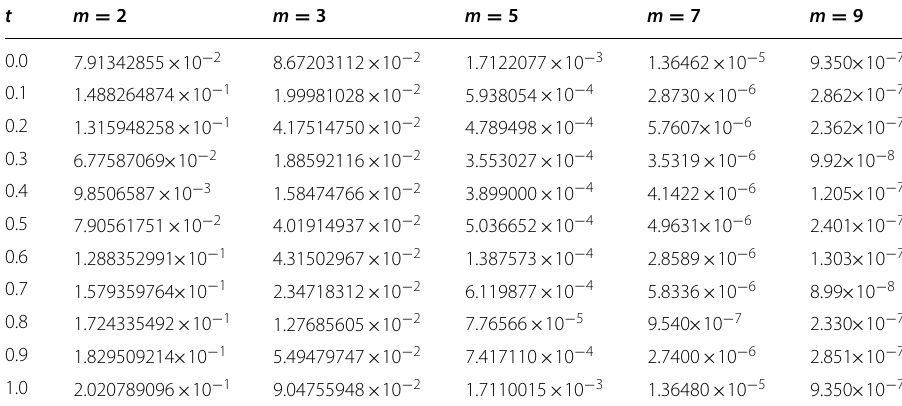
Table 2 Absolute errors for Example 1 given by � y e − y a